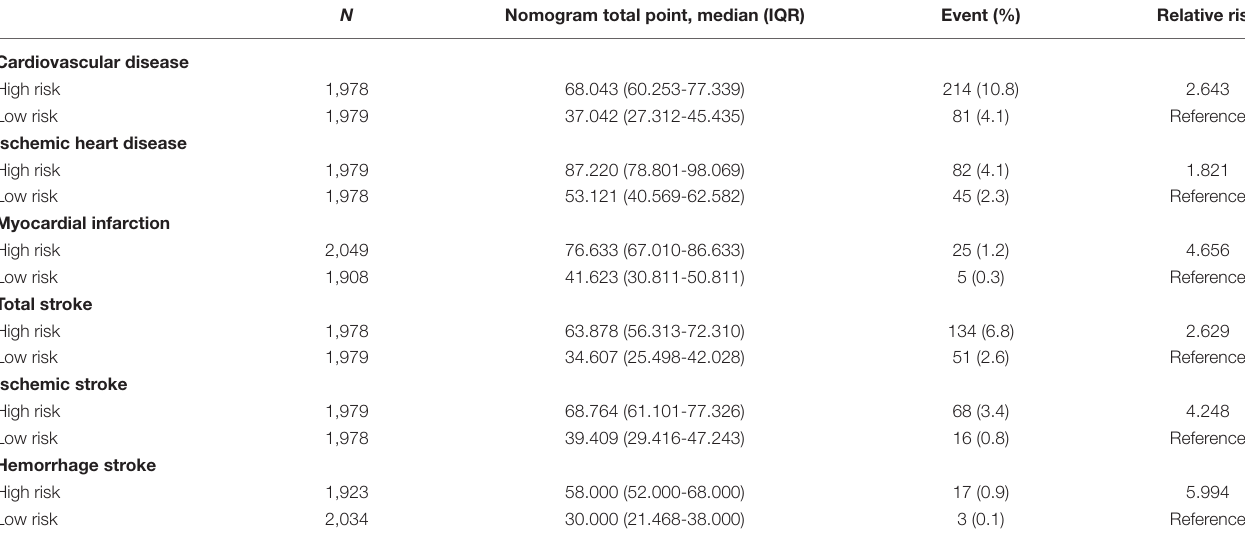
TABLE 3 | Median nomogram point-stratified cardiovascular disease event distribution in validation cohort. N Nomogram total point, median (IQR) Event (%) Relative